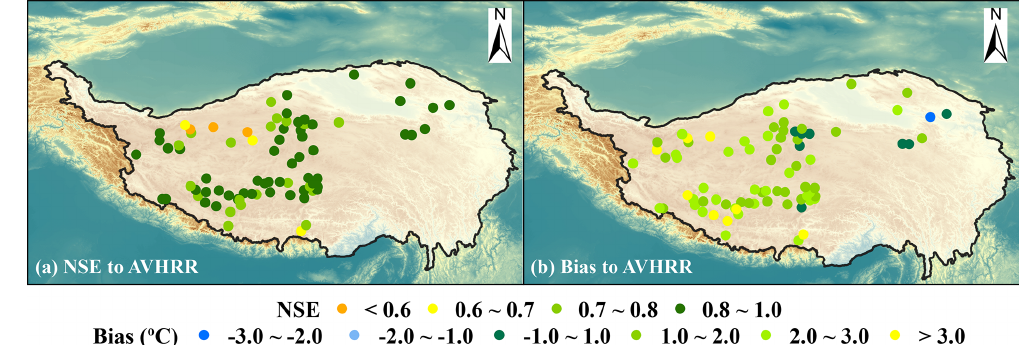
Figure 3. Comparison of LSWT from MOD11A1 and AVHRR LSWT for 77 lakes evaluated by NSE (a) and bias (b)